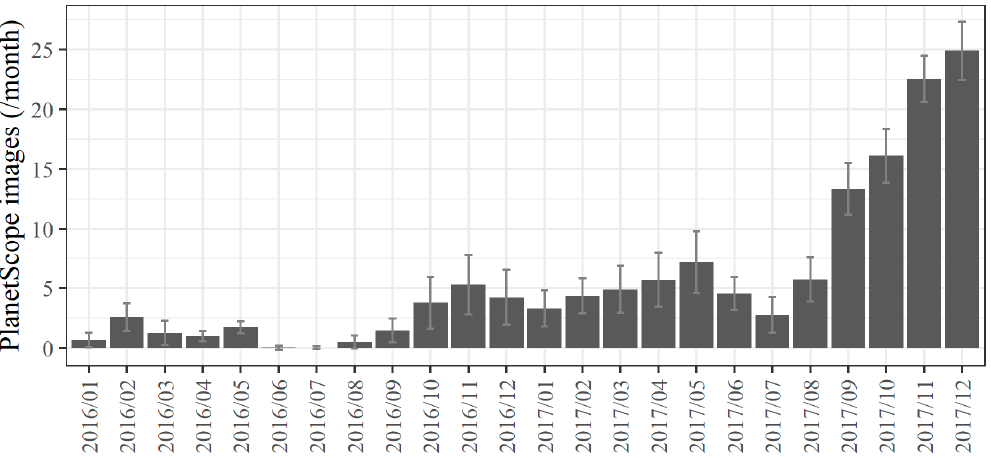
Figure 4. PlanetScope and RapidEye images used in visual interpretation. This represents the average number of available images for each reference sample. Error bar indicates standard deviation of the number of available images in each month. Note that these figures include cloud-contaminated images.